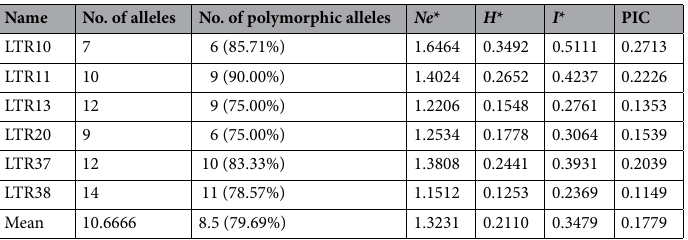
(Supplementary Figure 1). The remaining 6 (12.5%) pairs of primers (4 from the copia 2 subfamily, 2 from the gypsy 2 subfamily) showed clear and stable amplified fragments with polymorphisms among the 105 resources. DNA fingerprinting and characteristics of RBIP markers. In the 64 bands of the 6 pairs of RBIP